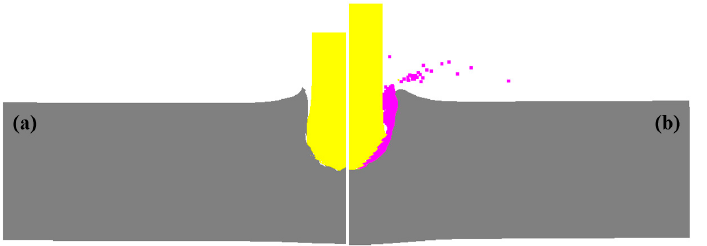
Figure 8. State comparison diagram of two projectiles penetrating to the half-depth of an armored steel target: ( a ) Standard projectile; ( b ) Ceramic composite projectile (Ø5 mm).